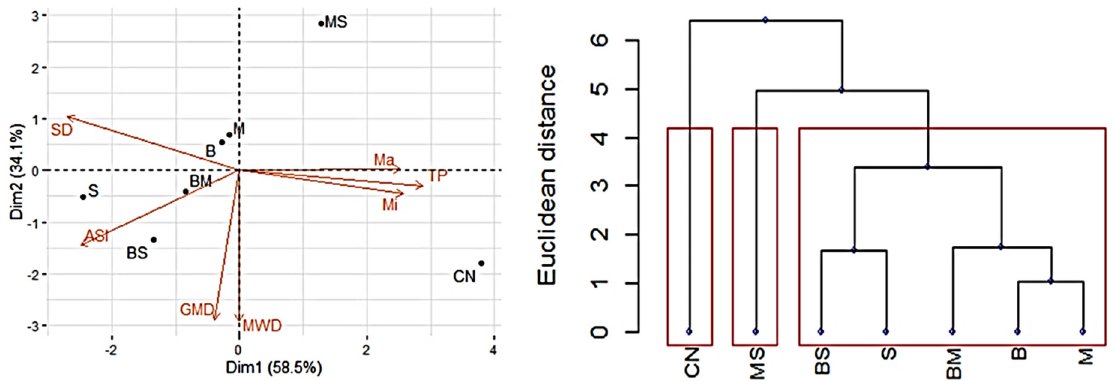
Figure 4. Principal components analysis, and cluster analysis of cover crops and Cerrado native area (CN) (0.2–0.3 m soil depth). B = Brachiaria, M = Pearl millet, S = Sunn hemp; BM = B + M; BS = B + S; MS = M + S; CN = Cerrado native. SD = soil bulk density; Ma = soil macroporosity; Mi = Soil microporosity; TP = Soil total porosity; MWD = Mean weight diameter; GMD = Geometric mean diameter; ASI = Aggregate stability index.